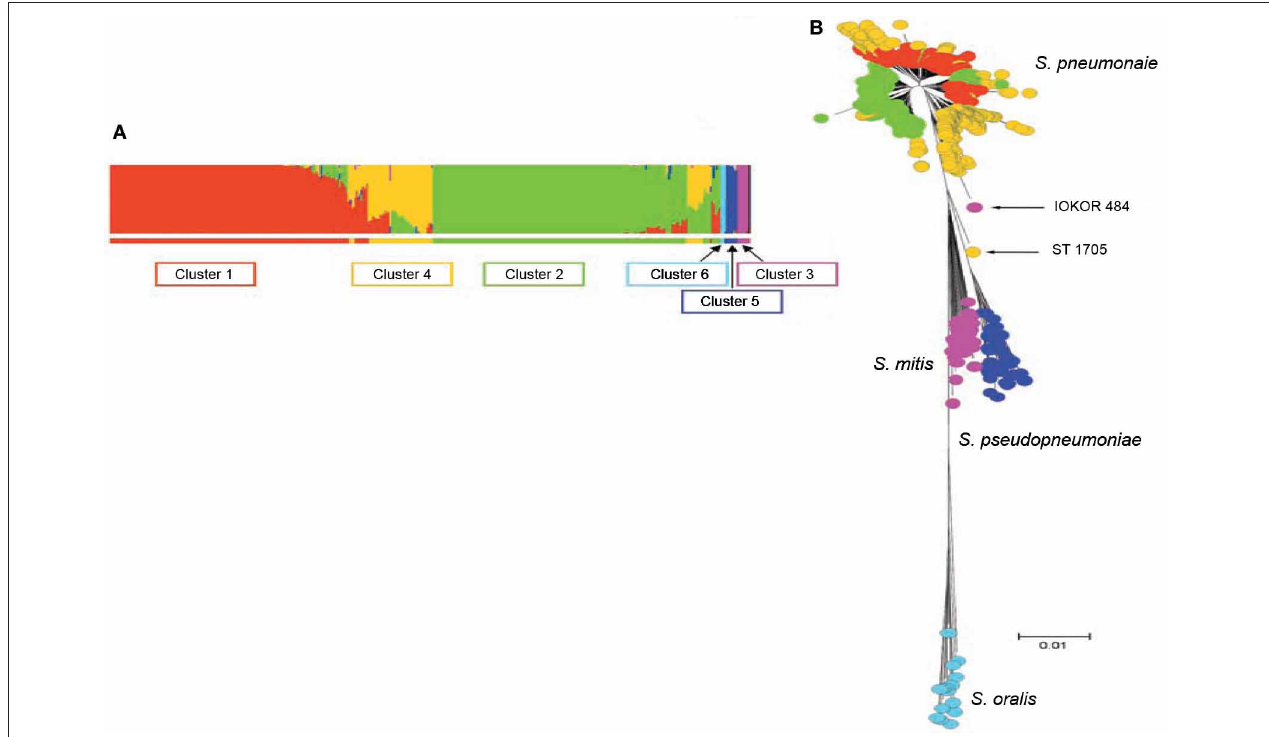
FIGURE 1 | (A) Admixture analysis of 2024 distinct streptococcal genotypes of S. pneumoniae, S. oralis, S. mitis, and S. pseudopneumoniae based on Bayesian Analysis of Population Structure. (B) Minimum evolution tree constructed from concatenates of the different streptococci species. The streptococci fell into six clusters shown by the different colors (coloring of taxa in B corresponds to colors of BAPS clusters in A ). Three BAPS clusters (including Clusters 1, 2, and 4) were associated